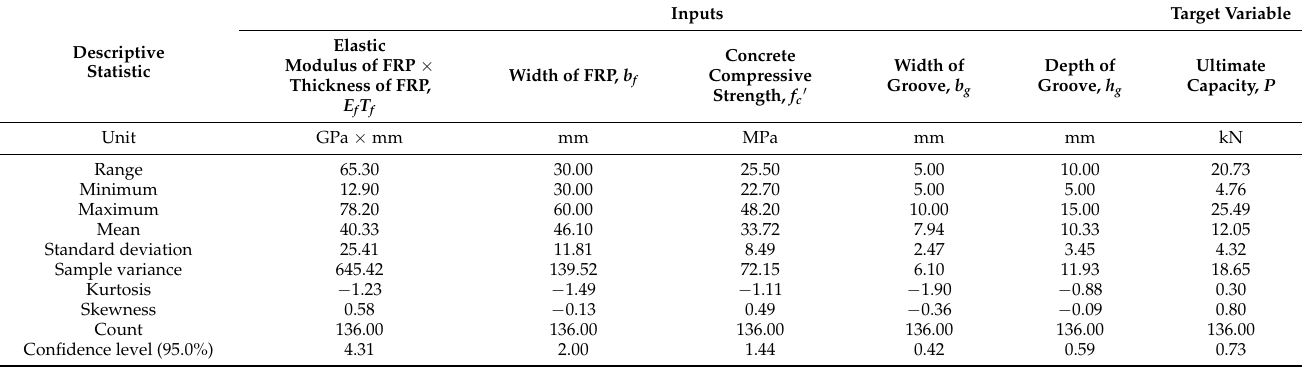
Table 4. Descriptive statistics of the collected